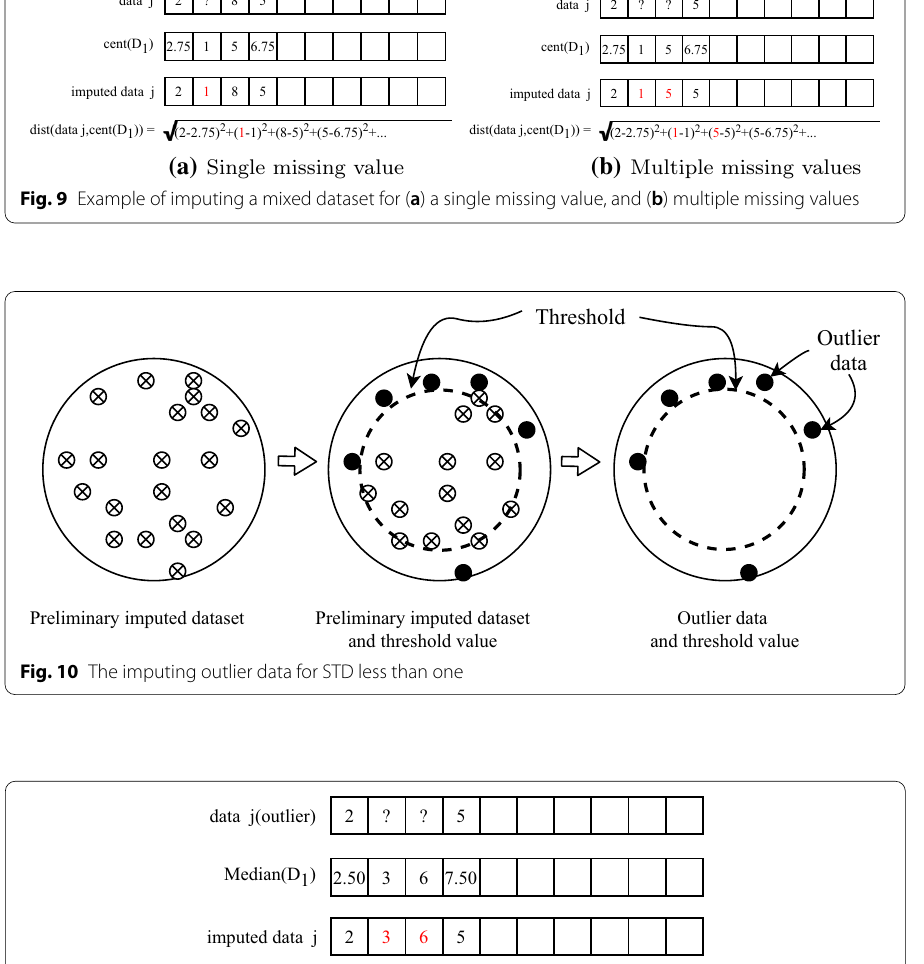
Fig. 11 Example of imputing outlier data with median